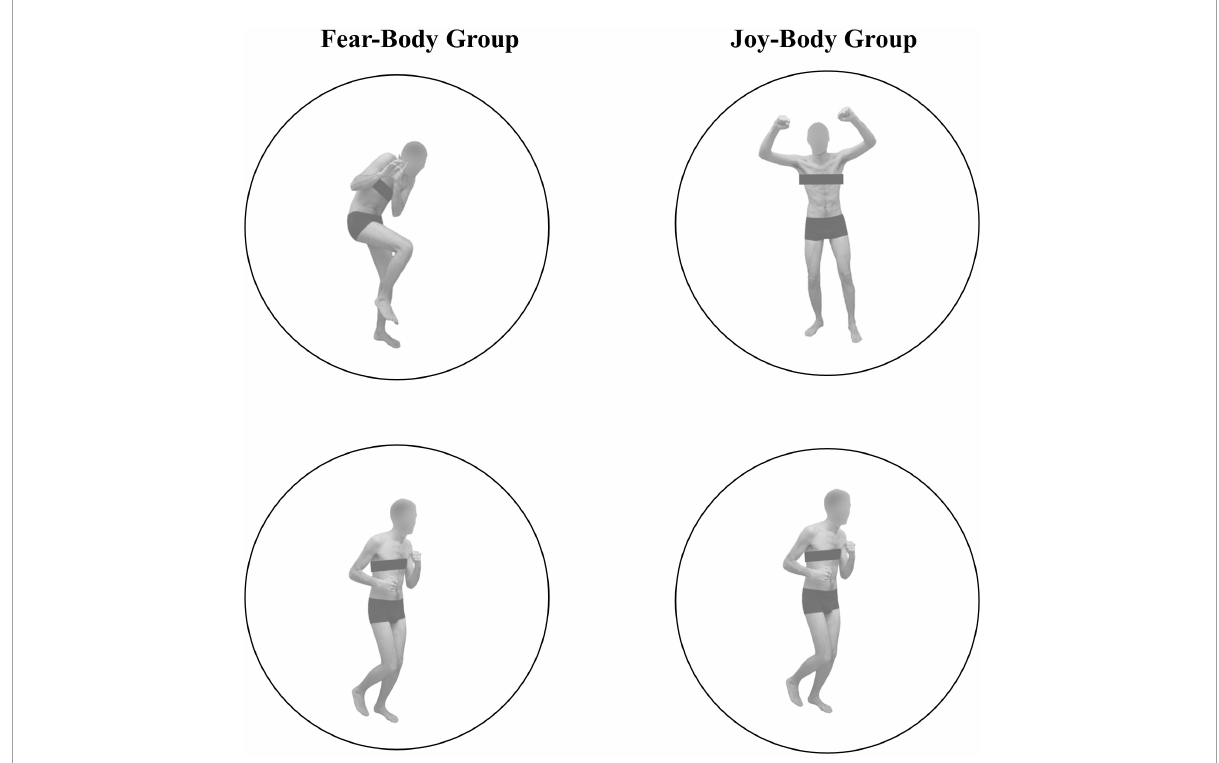
FIGURE1 Visual stimuli used as Stop-Signal stimuli. In the Fear-Body group, stimuli consisted of two different body pictures with fearful and neutral body expression, and in the Joy-Body group stimuli were represented by happy and neutral body postures, previously used and validated in Borgomaneri et al., 2012, 2015a,b,c, 2017, 2020b,